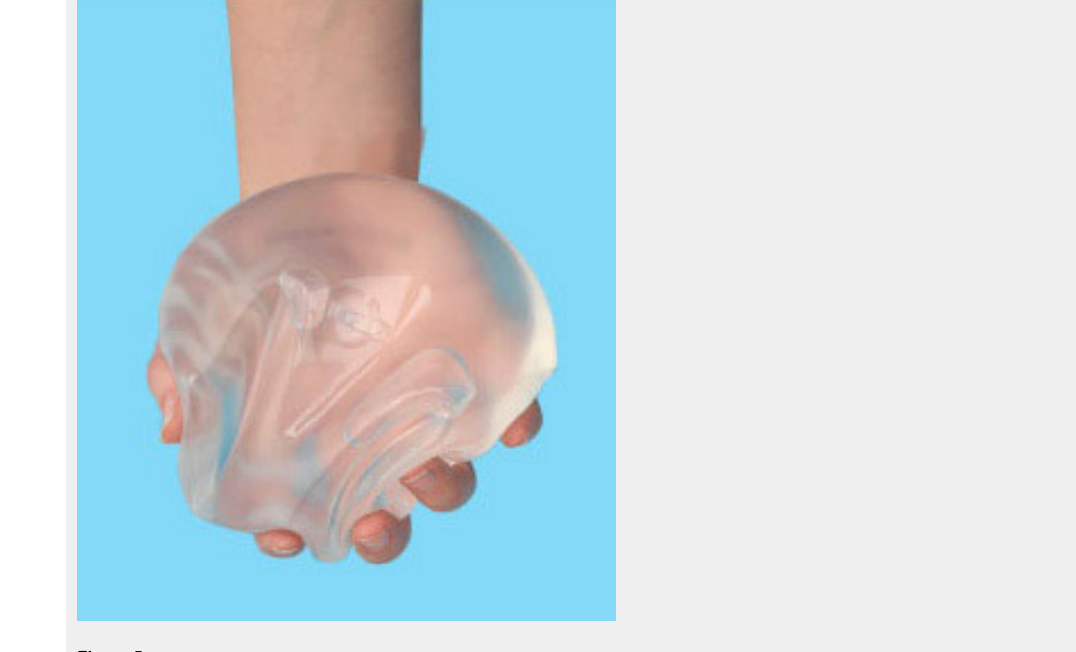
Figure 5 SSilicone rubber breast implant shell, to be filled with saline during surgery. In-situ filling allows for custom volume adjustment. If later (e.g., years) after implantation the saline-filled shell ruptures, the saline disperses rapidly and harmlessly, but makes a highly obvious change in the recipient’s appearance. © Natrelle. Reprinted with